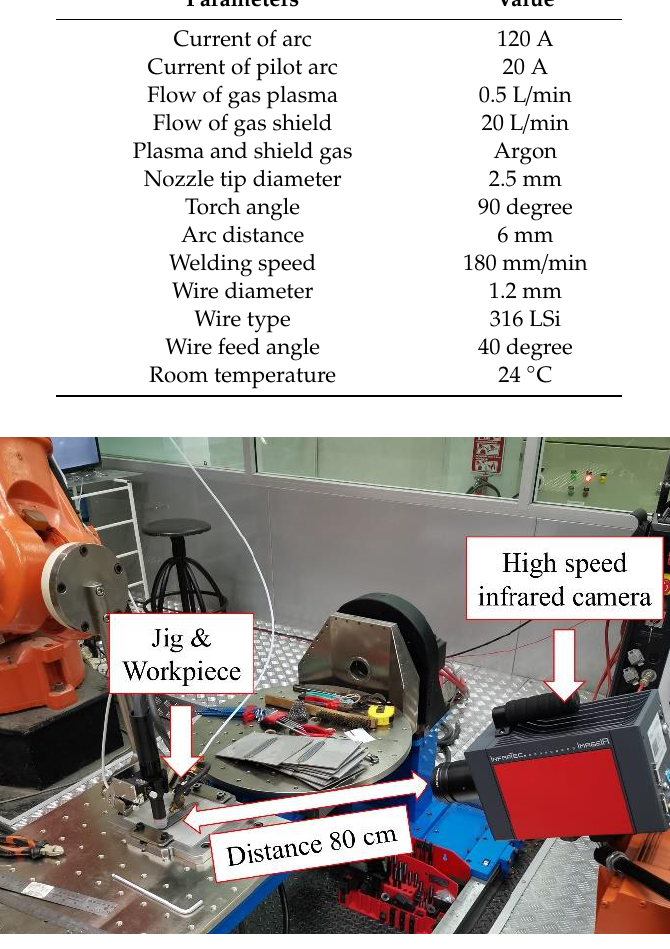
Figure 2. Installed high-speed infrared thermography camera.